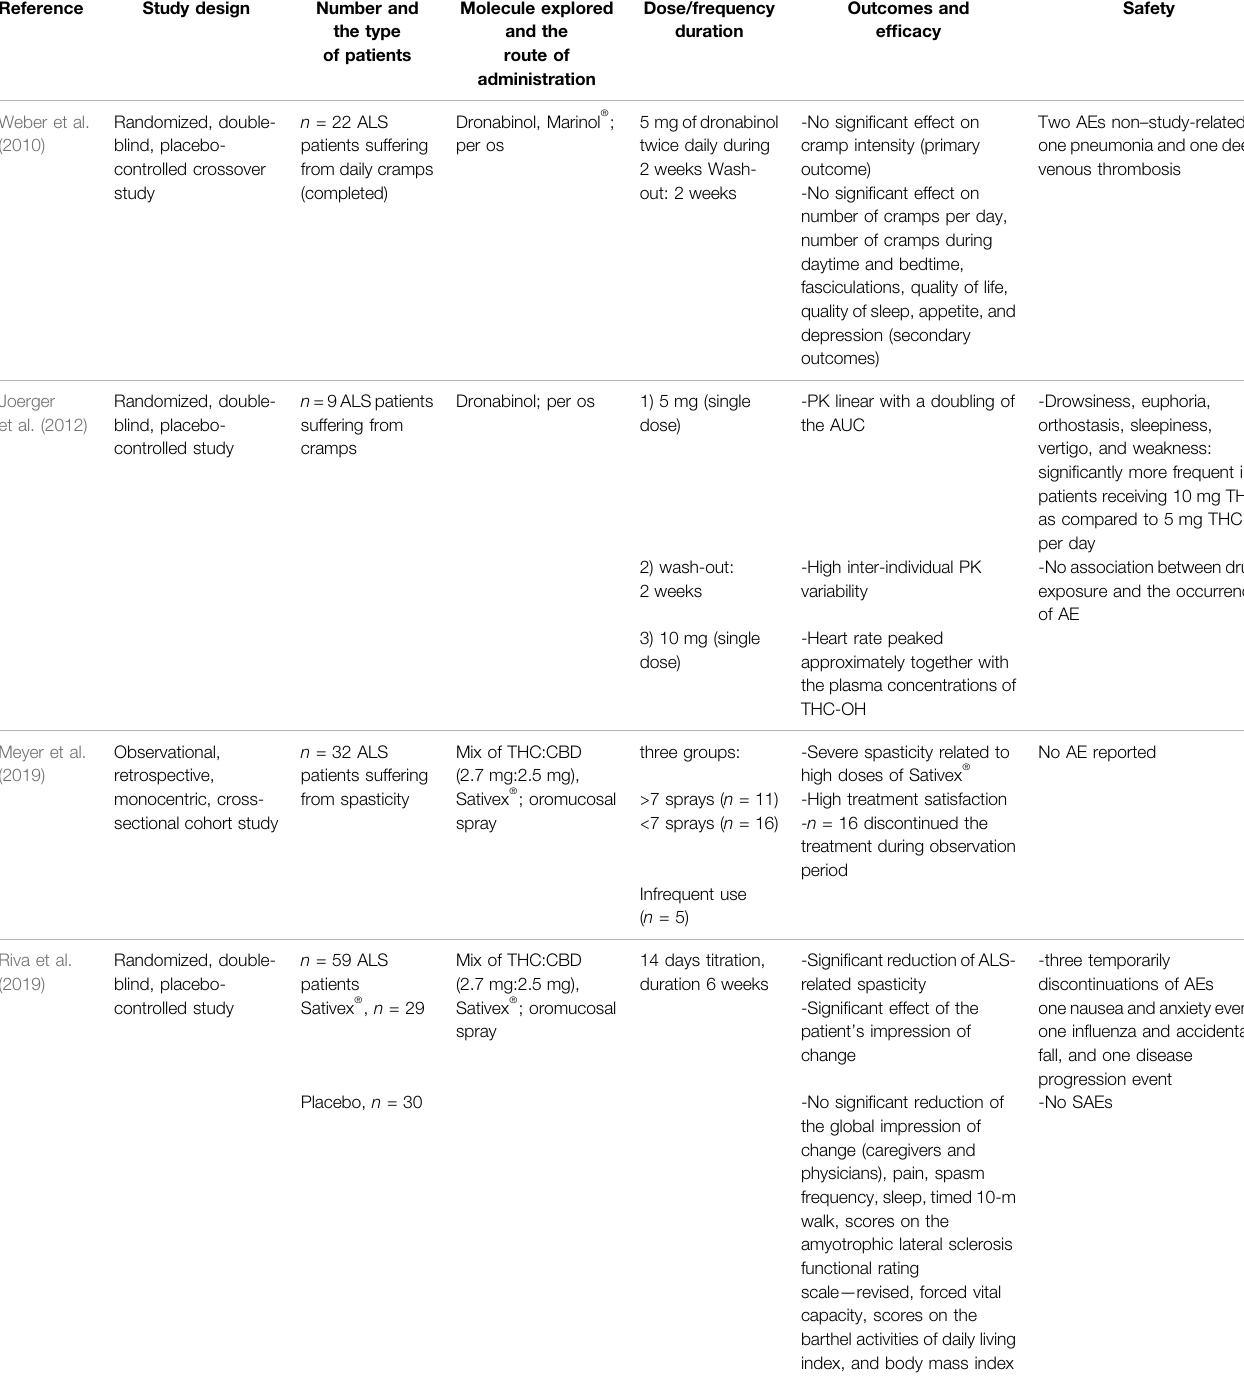
TABLE 1 | Summary of clinical studies exploring medical cannabis in